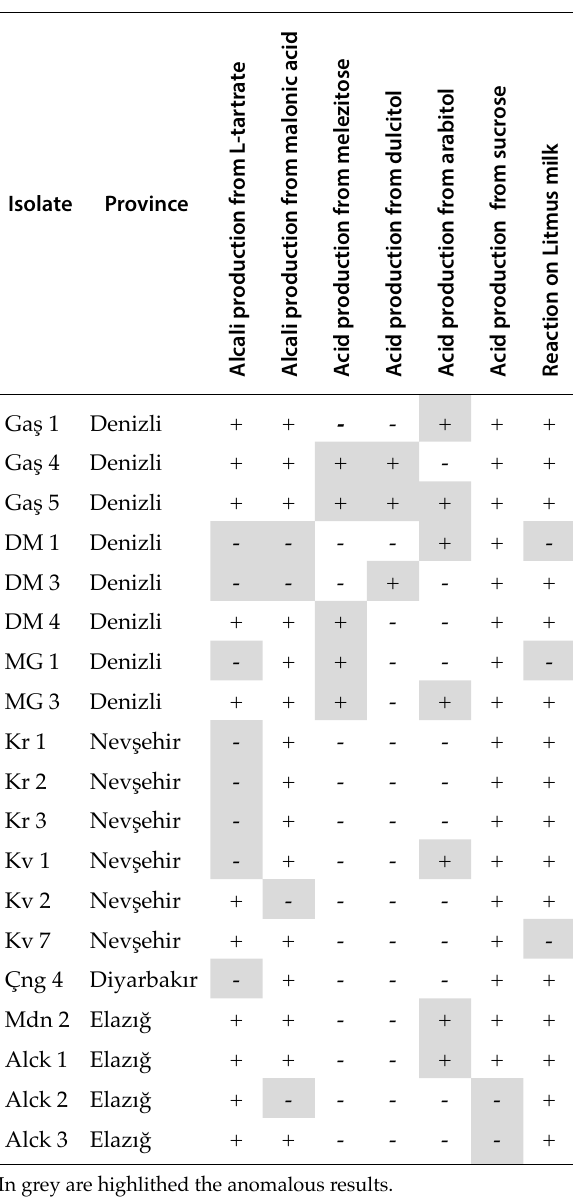
Table 4. Divergent strains of Rhizobium vitis as indicated by biochemical and physiological tests.